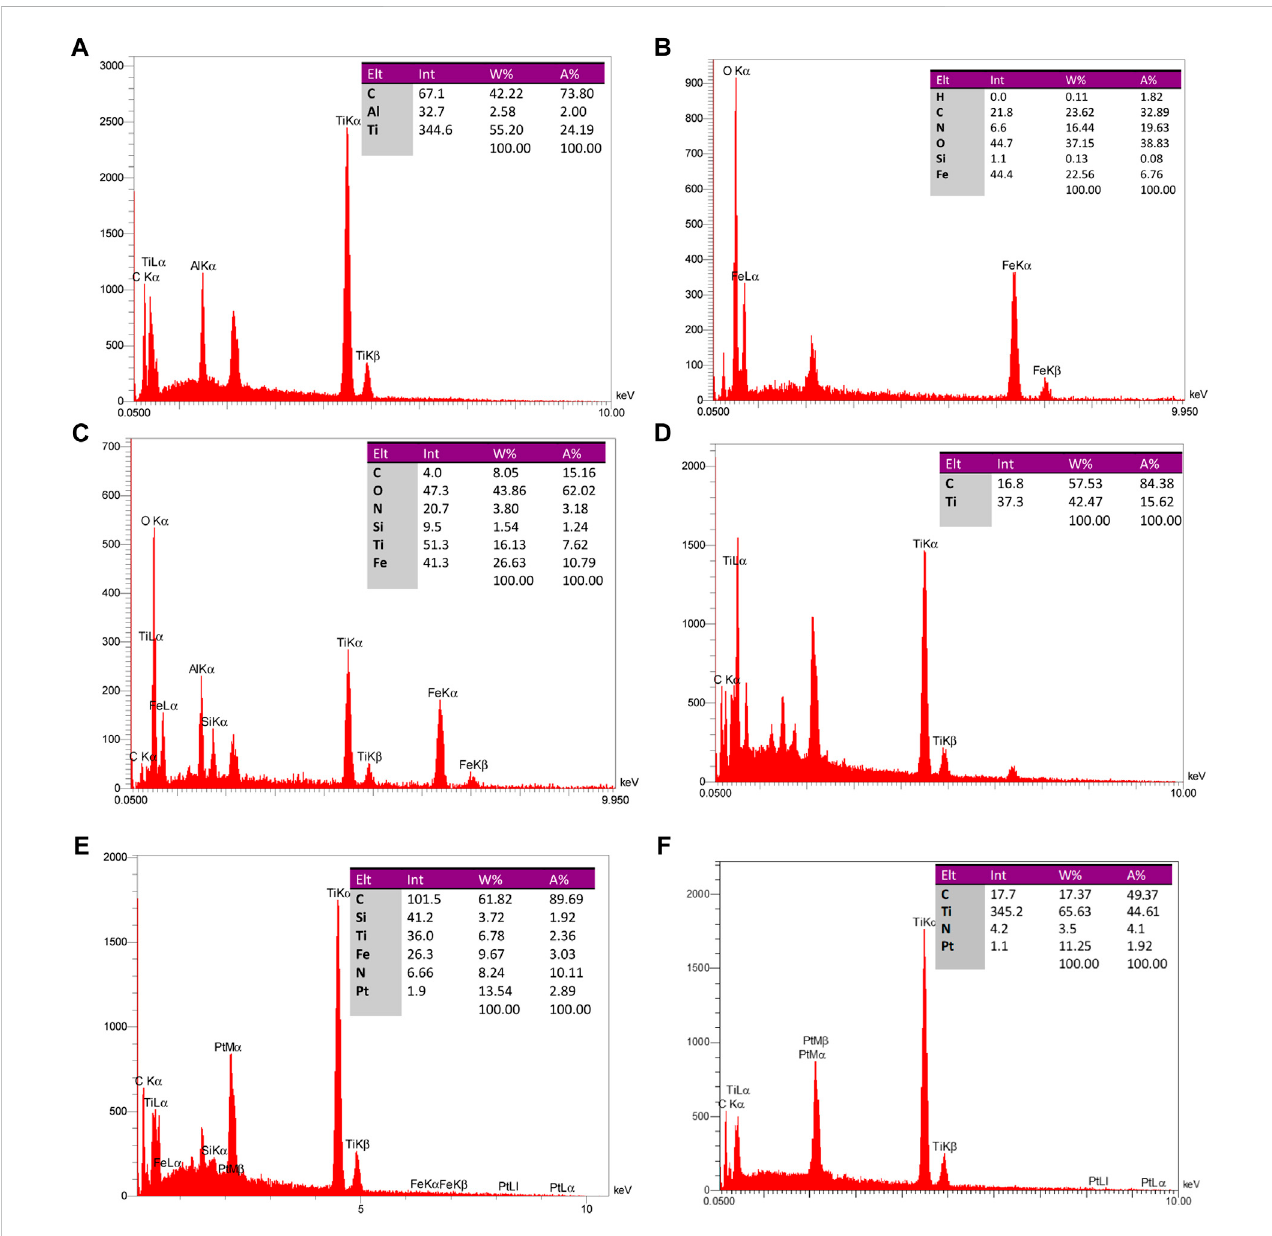
FIGURE 6 EDAX analysis of particle constituents of (A) Ti 3 AlC 2, (B) Fe 3 O 4 @SiO 2 , (C) Ti 3 C 2 -Fe 3 O 4 @SiO 2 -FA, (D) Ti 3 C 2 @FA, (E) Ti 3 C 2 -Fe 3 O 4 @SiO 2 -FA-Cisplatin, and (F)